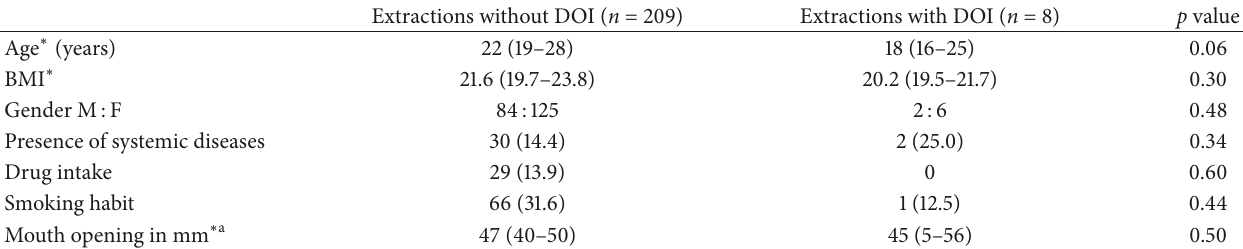
Table 1: Association between patient-related characteristics and delayed-onset infection (DOI).